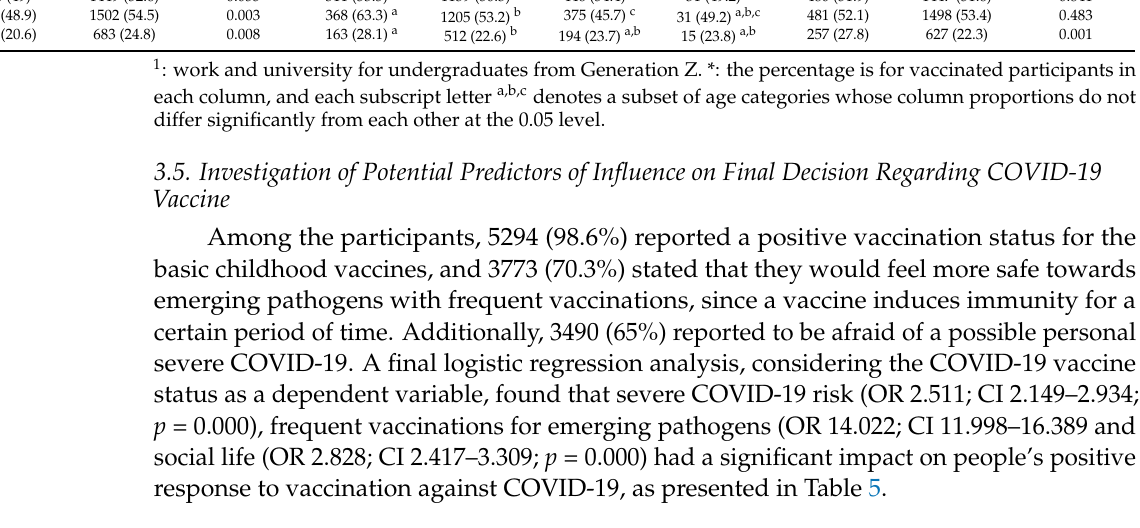
Table 5. Logistic regression for the influence to the response to COVID-19 vaccination, n =